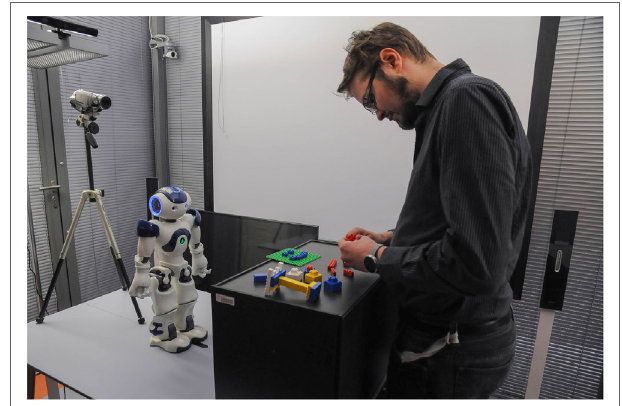
FigUre 4 | Participant interacting with the robot during the legO building session